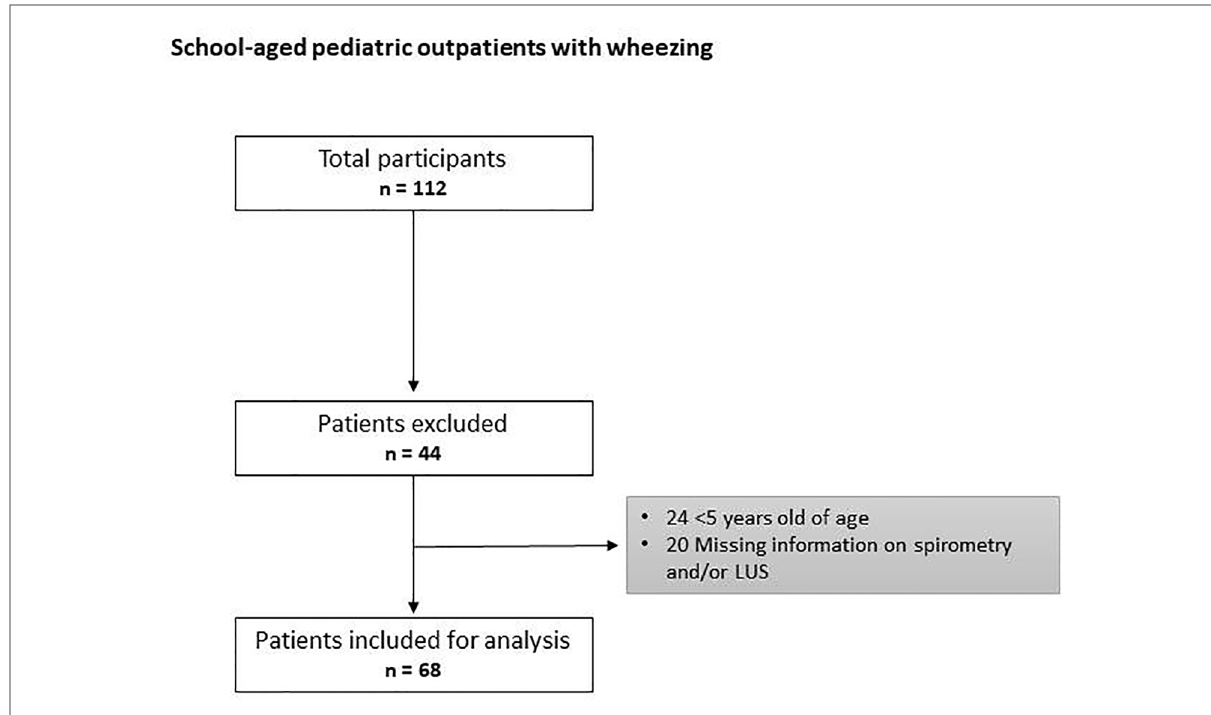
FIGURE 1 Flow-chart of the study. LUS, lung